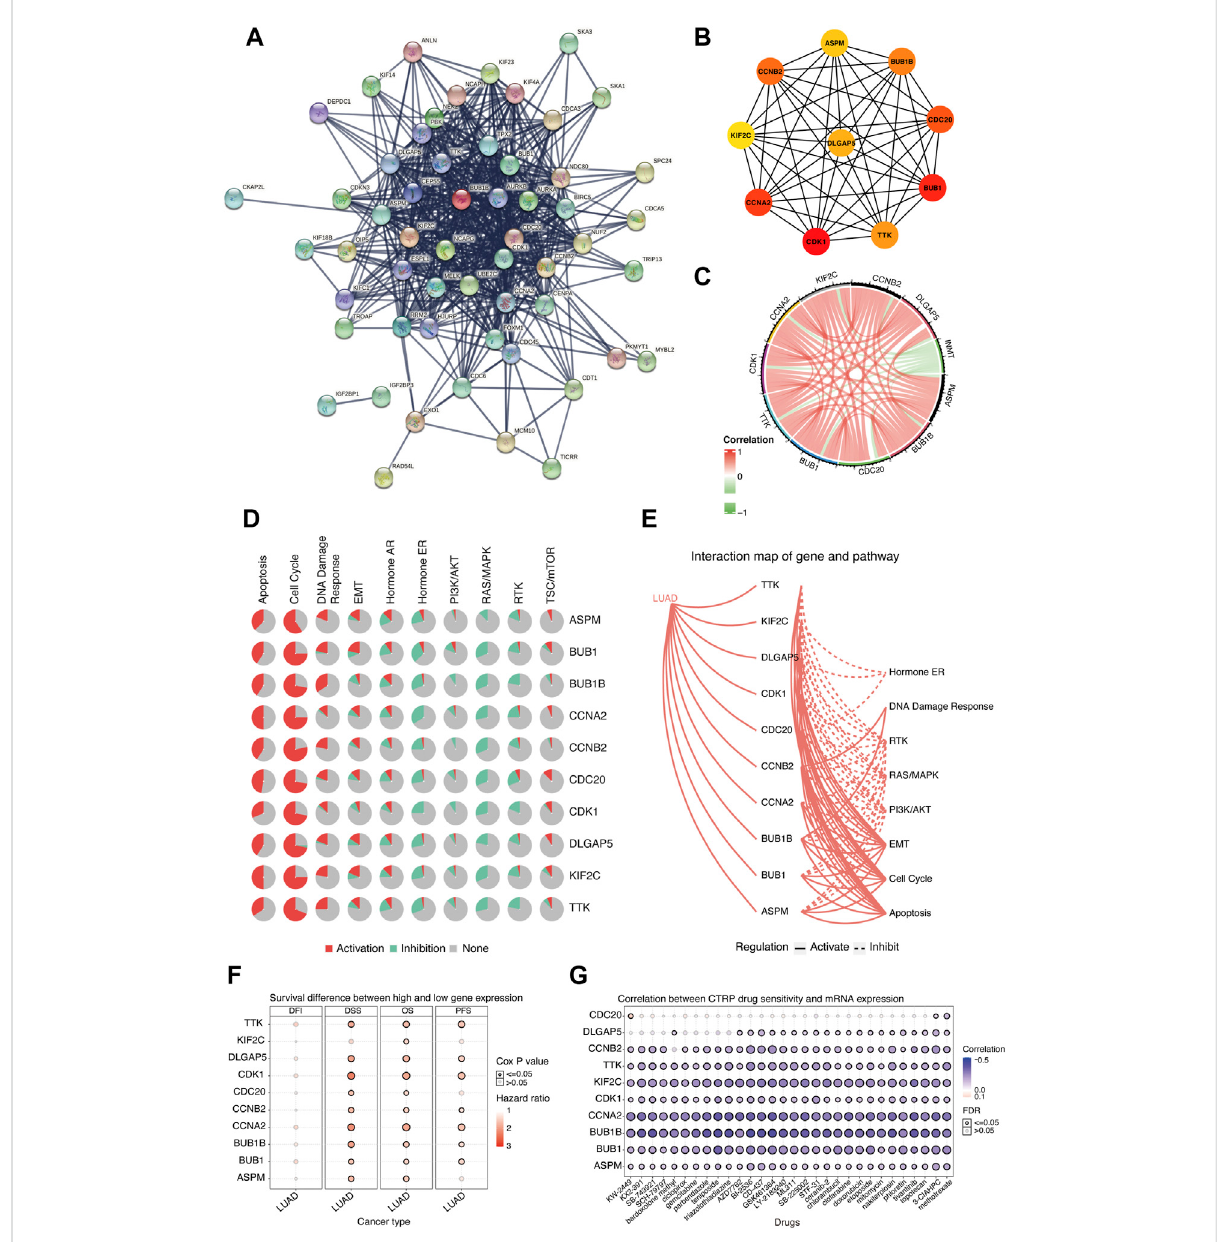
FIGURE 6 Biological function analysis of hub genes that were upregulated in the INMT low-expression group of TCGA-LUAD cohort. (A) Protein – protein interaction (PPI)networkofupregulatedgenesintheINMTlow-expression groupconstructed basedontheSTRINGdatabase. (B) Top10hubgenes identi fi ed using the MCC method in the cytoHubba plugin of Cytoscape. (C) Chord plot for the correlation of INMT and its hub genes. (D) Pathway activity analysis of hub genes. Pathway activation (red) represents the percentage of cancers in which pathways may be activated by given genes, and inhibition in a similar way showed as pathway inhibition (blue). (E) Interaction map of hub genes and pathway conducted. A solid line indicates thatthehub geneactivates thepathway, andadashed lineindicates that thehubgeneinhibits thepathway. (F) Survival difference between the high and low expression of hub genes. (G) Correlation between the expression of hub genes and CTRP drug sensitivity. The analyses of Figures 5D – G were performed online in GSCALite. LUAD, lung adenocarcinoma; PPI, protein – protein